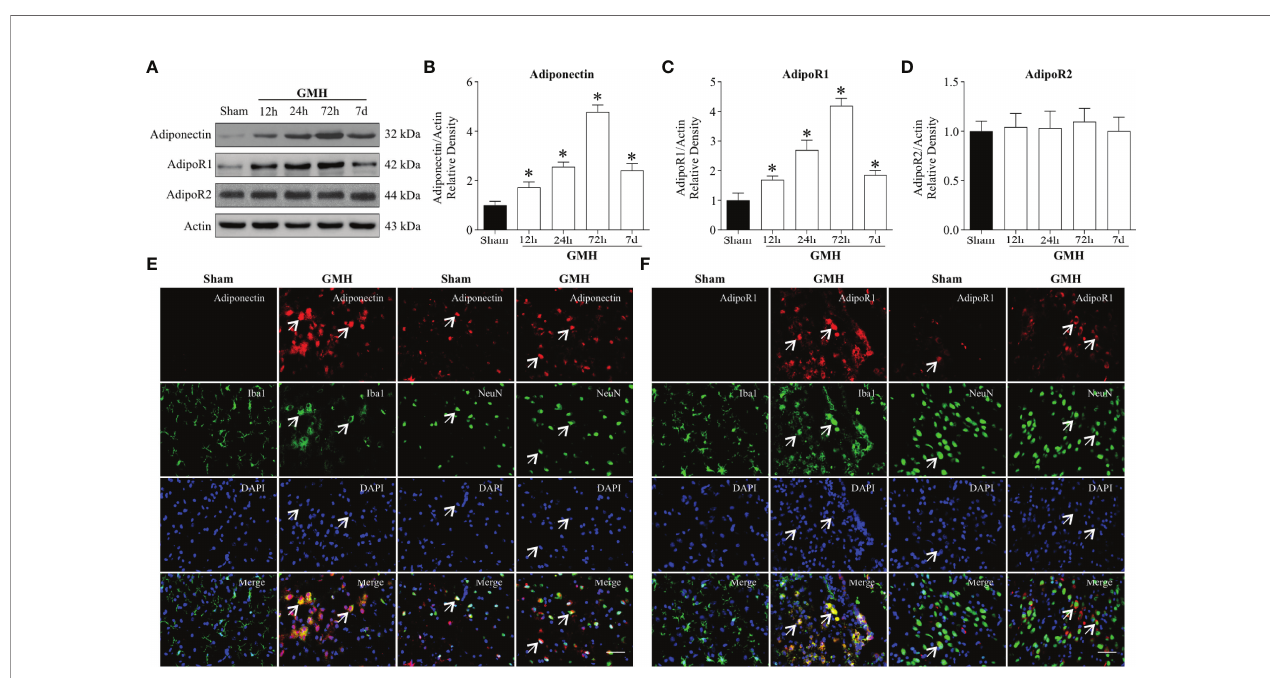
FIGURE 1 | Endogenous Adiponectin and AdipoR1 were upregulated in the brain after GMH. (A – C) Western blot data revealed that the endogenous Adiponectin (A, B) and AdipoR1 (A, C) expression levels signi fi cantly increased from 12 h to 3 d and peaked at 3 d post-GMH. (A, D) AdipoR2 expression levels were comparable among pups with or without GMH at four time points. Values are expressed as normalized to Actin protein expression. Values are expressed as mean ± SD. ANOVA, Dunnett. * P < 0.05 compared to sham, n = 6 for each group. (E, F) Representative images of immuno fl uorescence staining showing the co-localization of Adiponectin and AdipoR1 (red) with microglia and neurons (Iba1, NeuN, green) in the pups with or without GMH. Adiponectin and AdipoR1 immunoreactivities were greater on microglia and neurons in the periventricular area at 72 h after GMH. Arrows indicated Adiponectin or AdipoR1 colocalized with microglia. Scale bar = 50µm. n = 3 for each